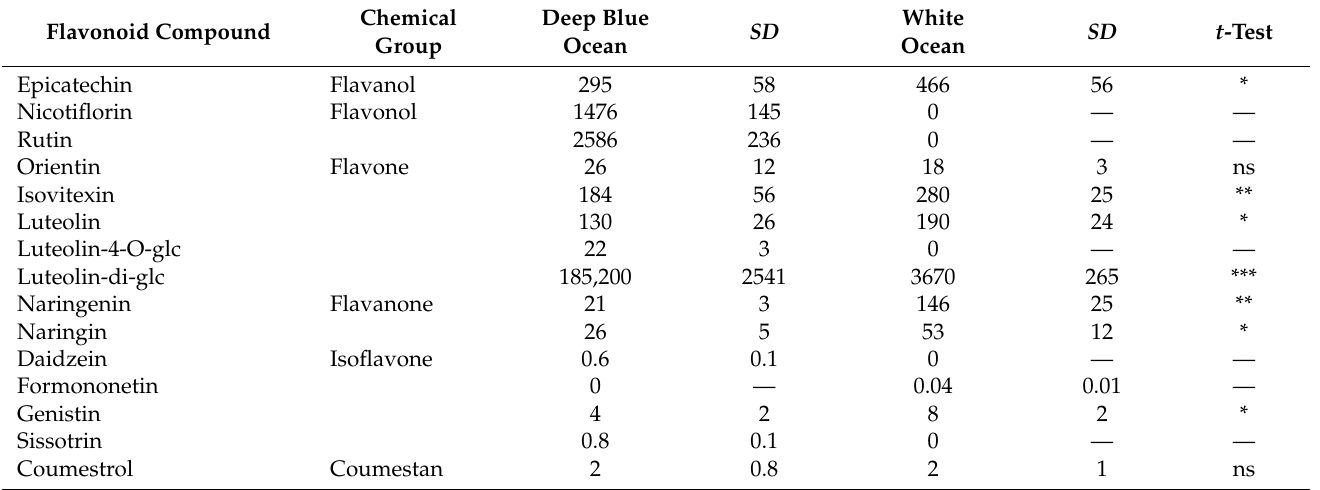
Table 3. Predominant flavonoids compounds in Deep Blue Ocean and White Ocean Campanula portenschlagiana stems. Flavonoid concentrations are expressed in ng/g of dry weight (DW) of the basal parts of